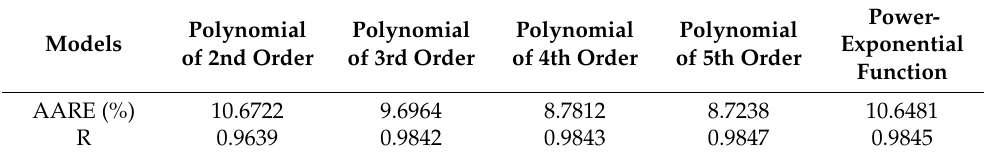
Table 2. The values of R and AARE of constitutive models.